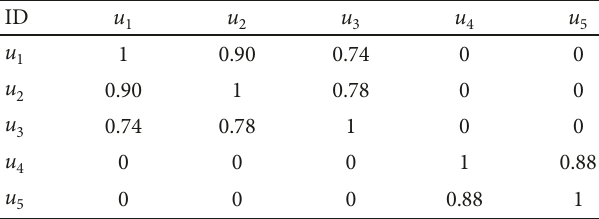
Table 2: Relation